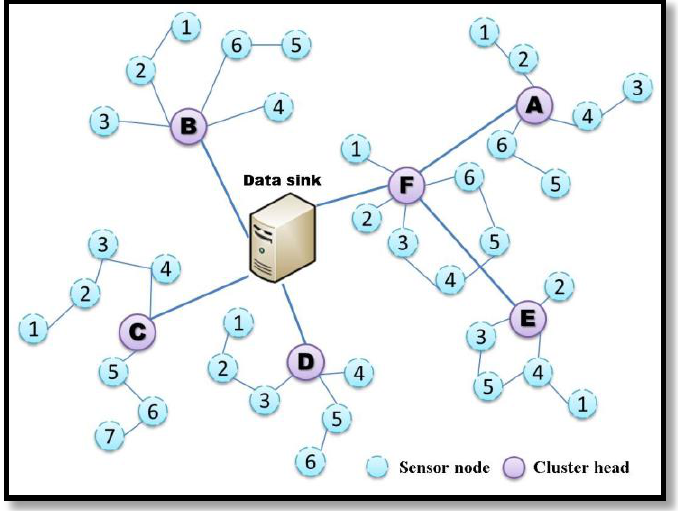
Figure 2. Three-tier network